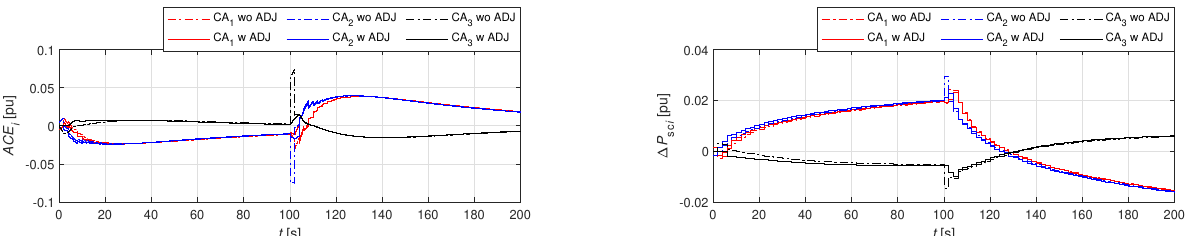
Figure 13. Time responses of ACE i ( left ) and time responses of ∆ P sc i ( right ) for a three-CA test system, where “wo ADJ” is without and “w ADJ” is with the P cor i adjustment